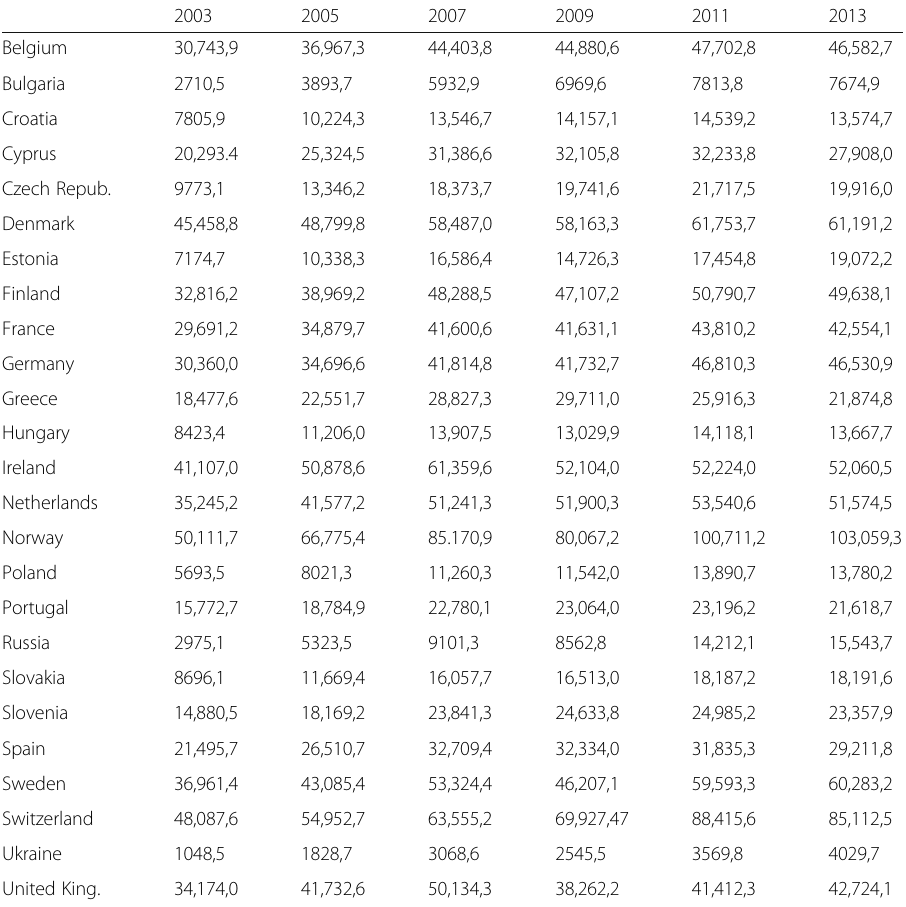
Table 2 GDP per capita (current